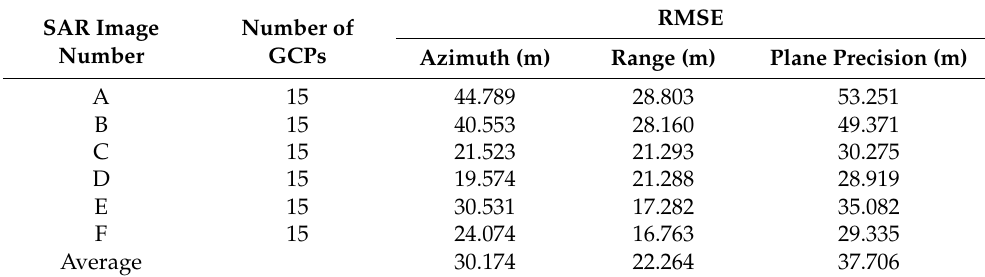
Table 3. Plane precisions of the test images before the geometric calibration process.